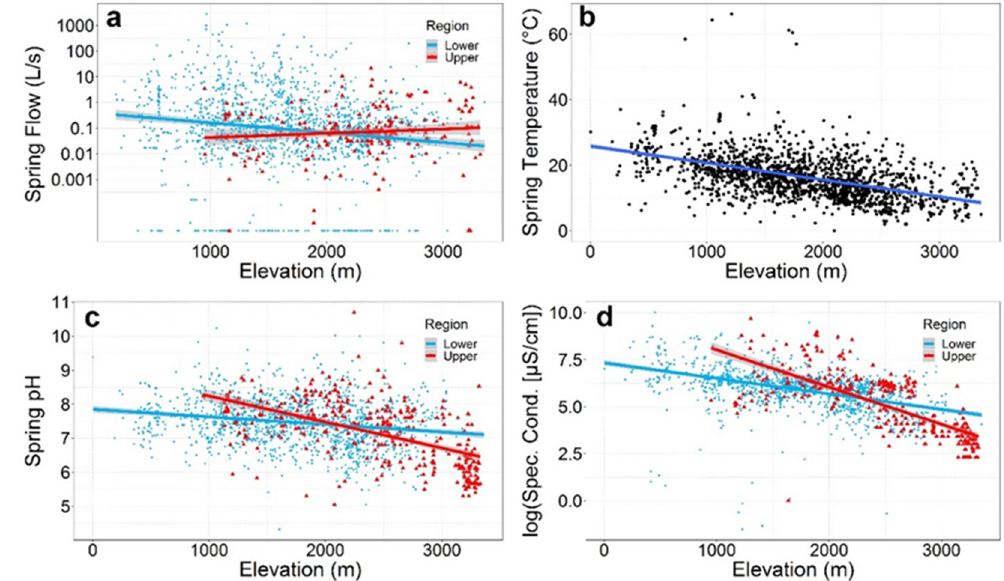
Figure 4. Springs discharge and water characteristics in relation to elevation in the Colorado River Basin: ( a ) springs discharge (L/s); ( b ) water temperature (°C); ( c ) pH; and ( d ) specific conductivity ( μ S/cm).